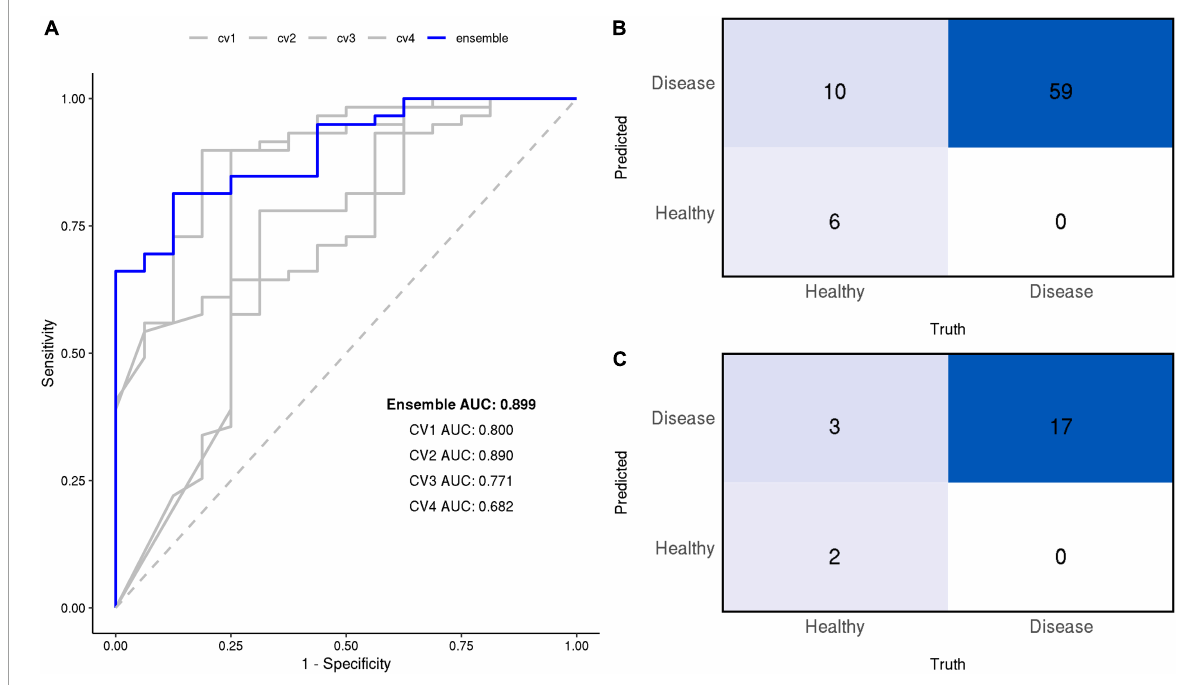
FIGURE4 (A) Receiver operating characteristic (ROC) curves of the final models at the sample level. Area under the ROC curve (AUC) is annotated for each model. The ensemble’s confusion matrix heatmaps at the sample (B) and patient (C) levels summarize the frequency of True Positives (TP),